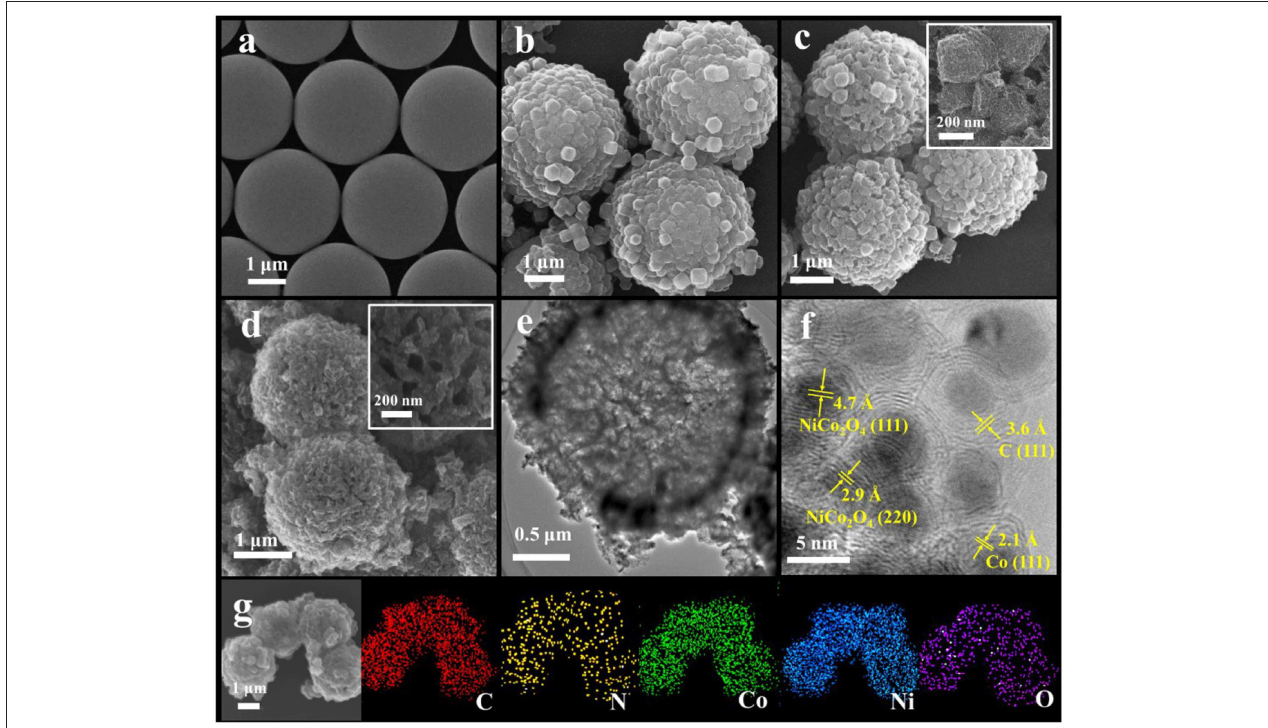
FIGURE 1 | SEM images of (a) PS microspheres, (b) PS@ZIF-67 microspheres, (c) PS@ZIF-67@NiCo-LDH microspheres, and (d) H-Co/N-C@NiCo 2 O 4 . (e) TEM and (f) HRTEM image of H-Co/N-C@NiCo 2 O 4 . (g) SEM and EDS elemental mapping images of H-Co/N-C@NiCo 2 O 4 .